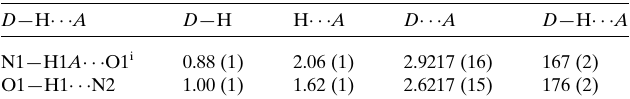
Table 3 Hydrogen-bond geometry (A˚ , (cid:4) ) for ( 4